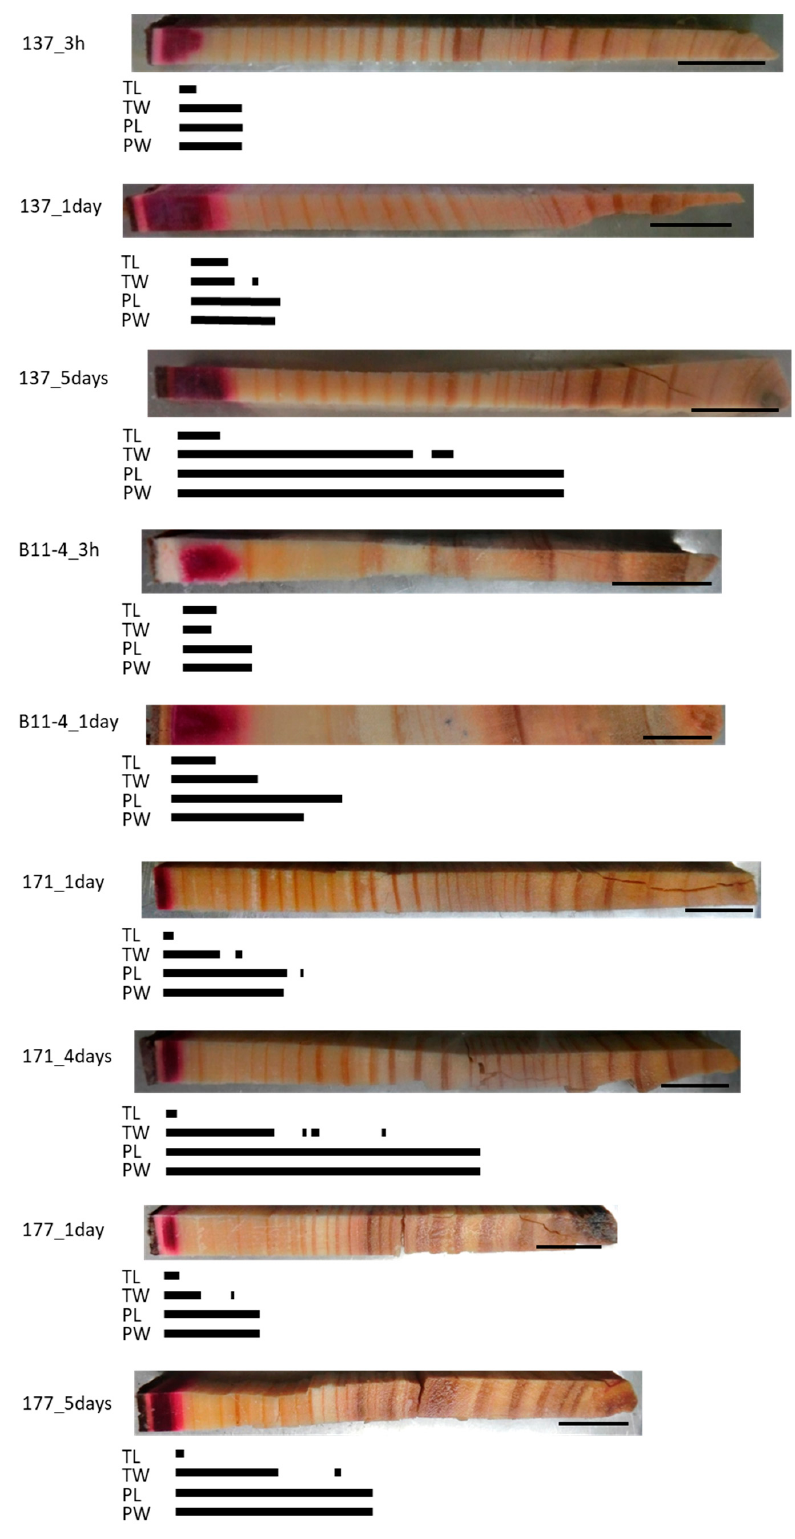
Figure 3. Schematic representation of radially distributed cesium (Cs) in the xylem of normal Japanese cedar ( Cryptomeria japonica ) trees after 3 h, 1 day, 4 days, or 5 days of injection, as observed using cryo-scanning electron microscopy / energy-dispersive X-ray spectroscopy (cryo-SEM / EDX). Abbreviations are the same as described in Figure 2.